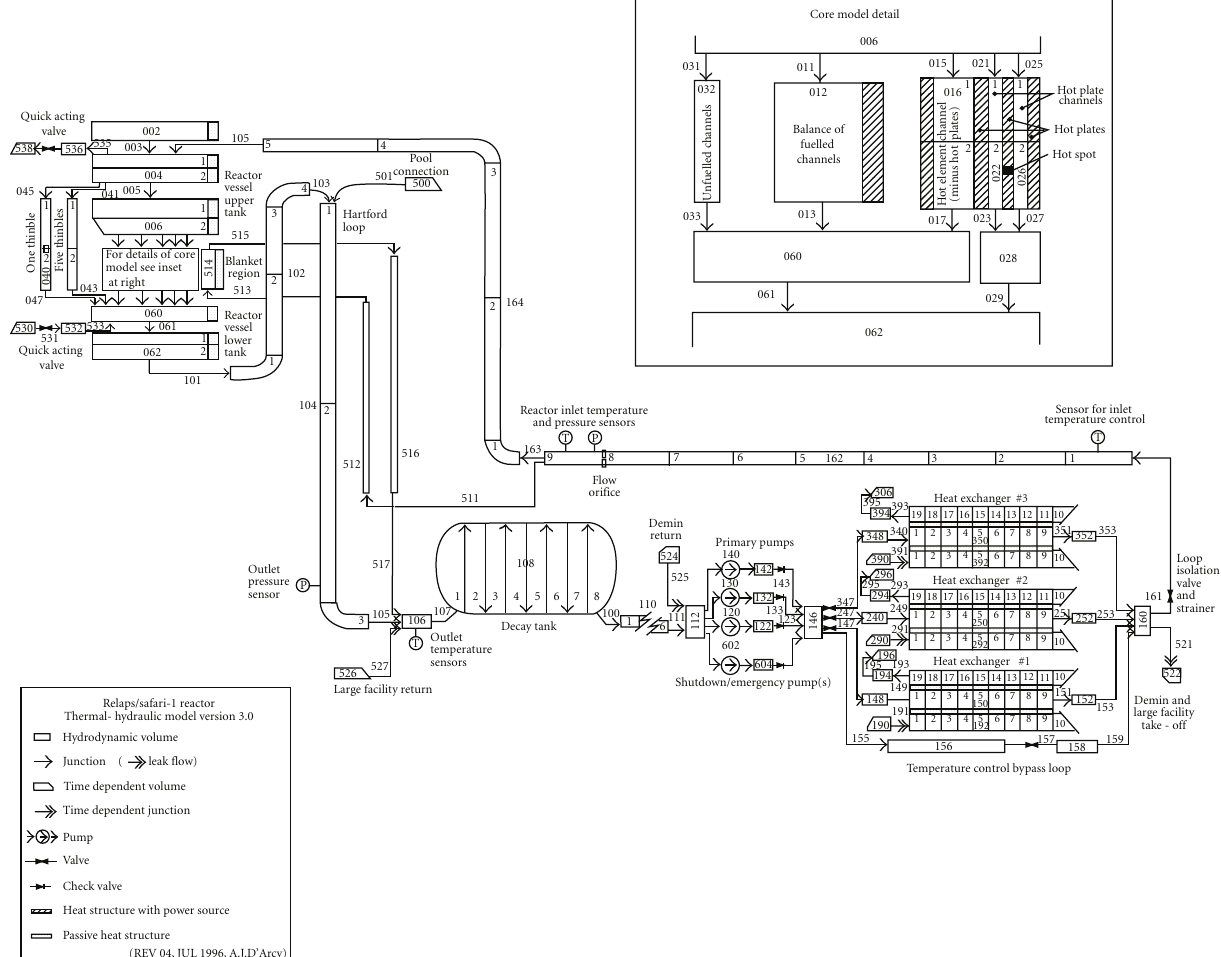
Figure 5: RELAP/SCDAPSIM nodalization of the SAFARI cooling system.